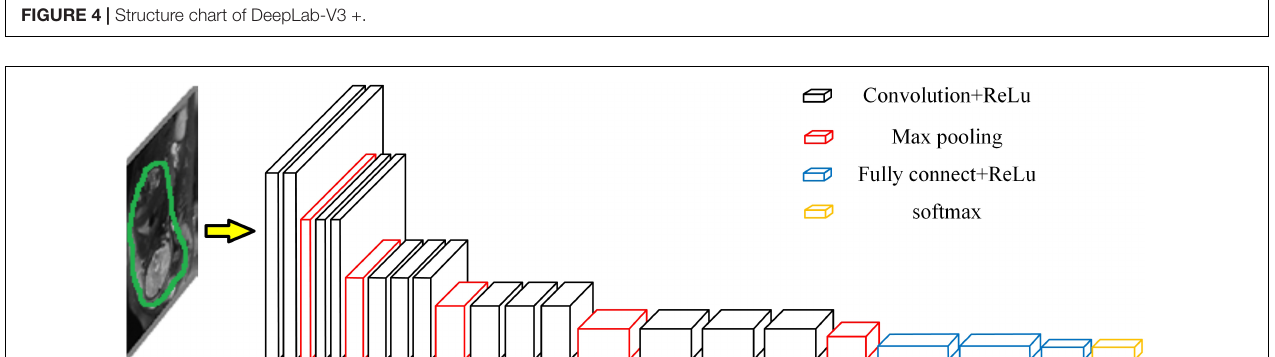
FIGURE 4 | Structure chart of DeepLab-V3 +.